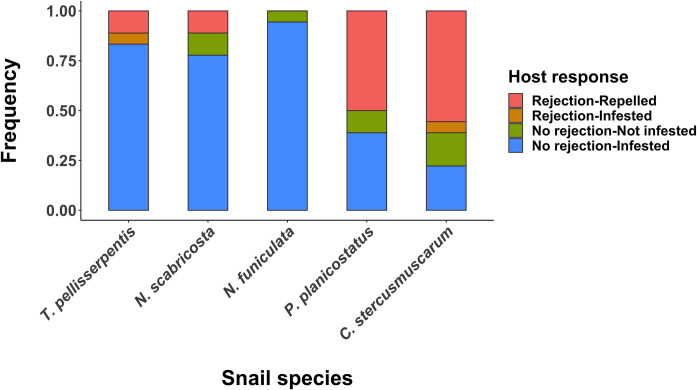
Host rejection behaviors and flatworm infestation success.Frequencies of different snail and flatworm responses during experimental infestation. The responses were classified as: the host rejects and repels the worm (red pink), the host rejects the worm, but the worm successfully infests the host (orange), the host does not reject the worm, but the worm does not infest the host (olive green), and the host does not reject the worm, and the worm successfully infests the host (light blue). Snail and flatworm responses were tracked over the allotted time period of 3 minutes using 18 different individuals for each species.